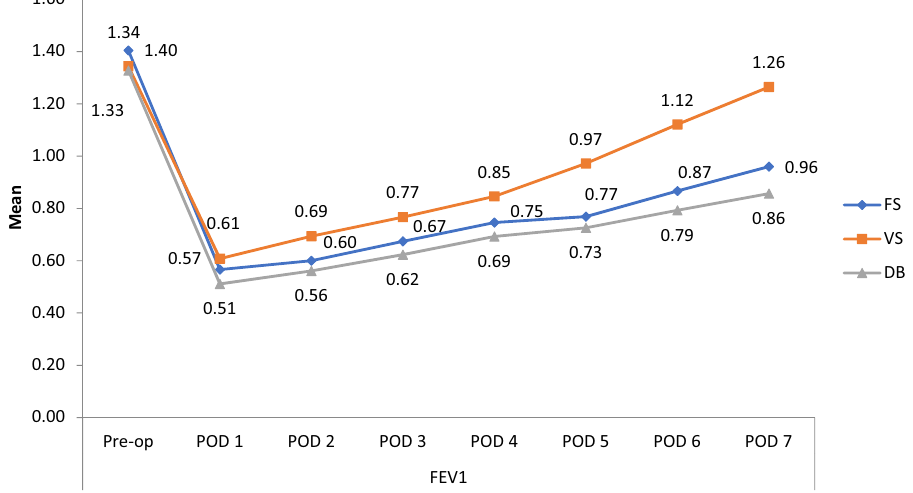
Figure 4. Comparison of forced expiratory volume in 1 s (FEV1) before and after coronary artery bypass graft surgery between three groups.